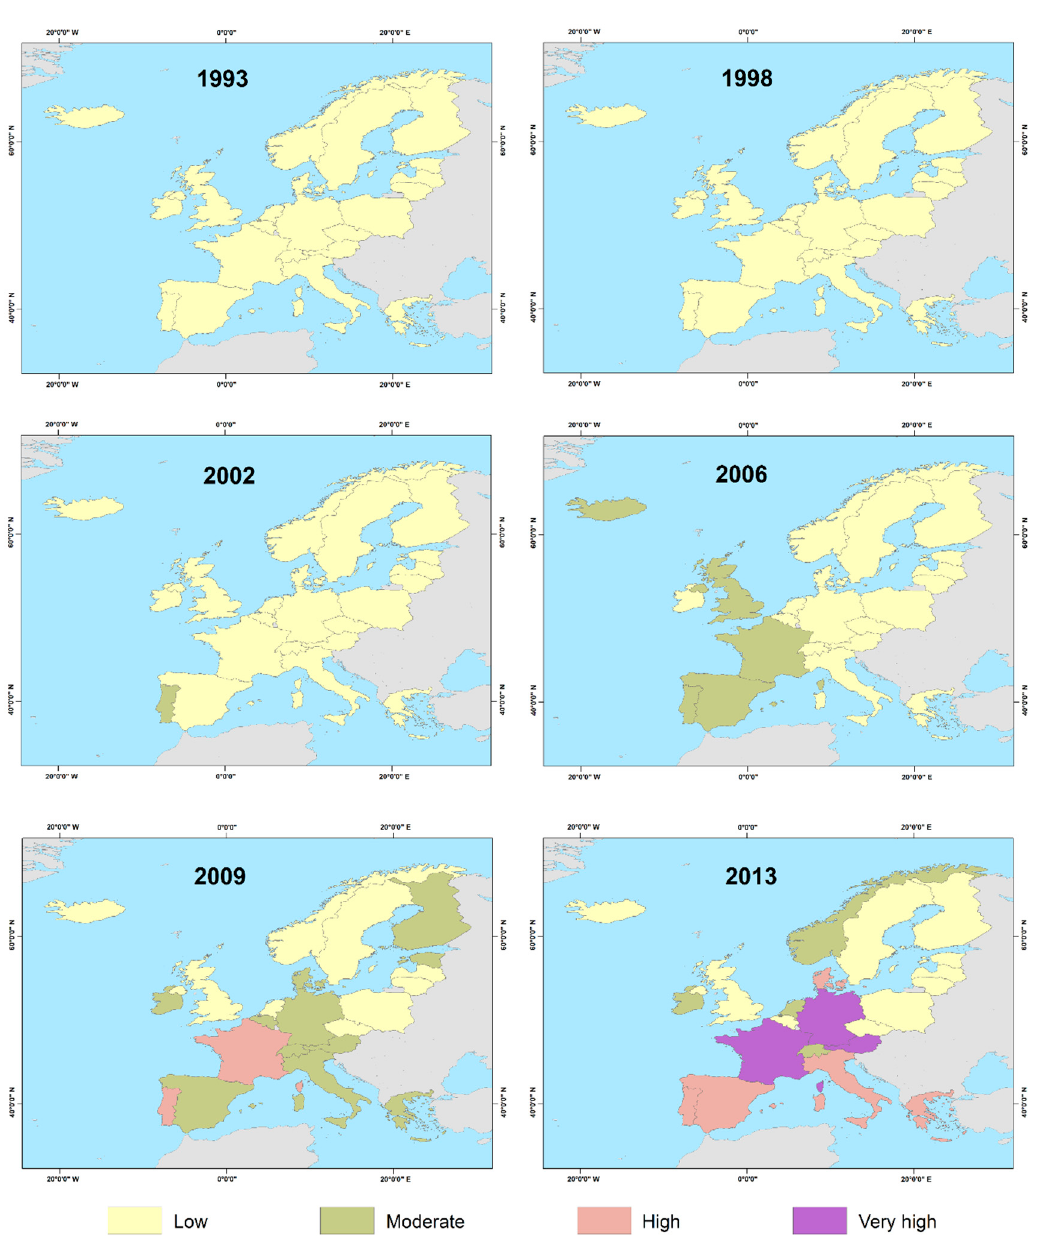
Figure 10. Population mortality due to hazardous events (parameter λ ) for male gender in 1993, 1998, 2002, 2006, 2009, and 2013.